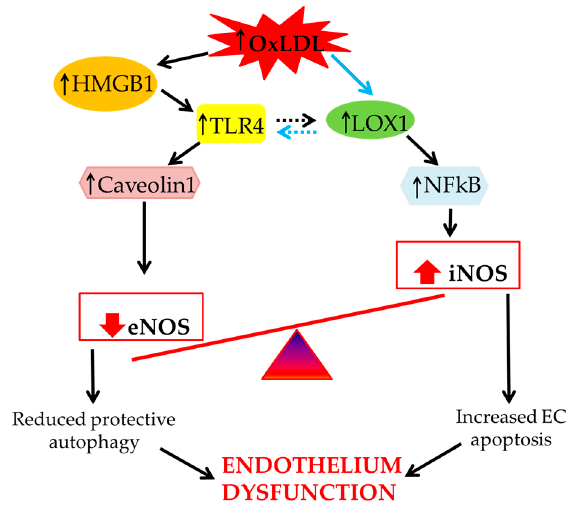
Figure 3. Proposed mechanism of oxLDL–related endothelial dysfunction via imbalanced regulation of the eNOS/iNOS relationship.